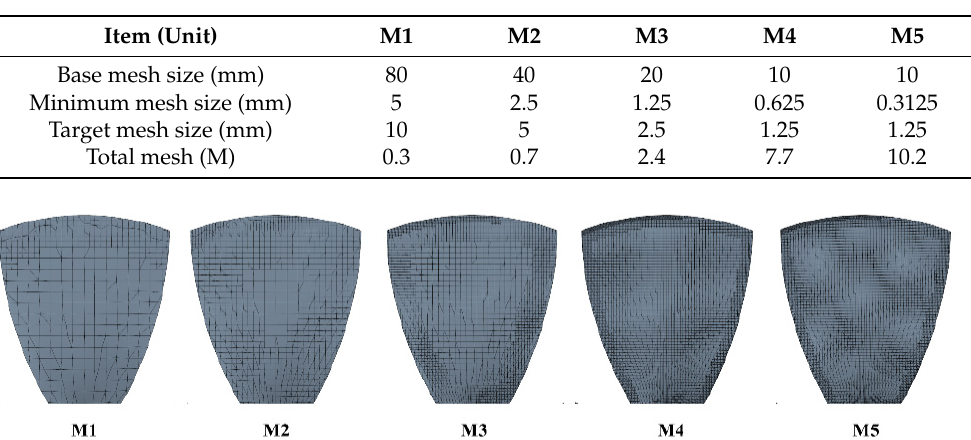
mesh quantity increased, demonstrating that the simulation results were convergent. Figure 6. Comparison of the experimental and simulated values of the efficiency η . A common advance speed coefficient of the Ka4-70 propeller in the 19A duct is 0.6. The simulation results of each mesh resolution with J = 0.6 were analyzed. The simulation results of the ducted propeller’s OWCs approached the experimental values as the mesh resolution increased, and the relative error of each group of simulations also gradually decreased, showing that the simulation results were gradually converging. Thus, the feasibility of the simulation was verified. The blue error bars were used to show the error of the simulated values relative to the experimental values, and the values were marked